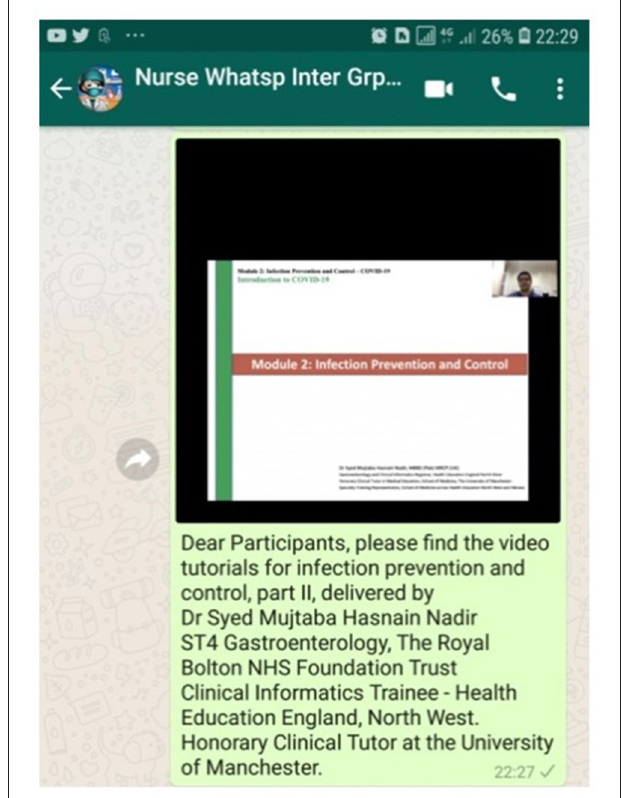
FIGURE 2 | Screenshot of a WhatsApp communication to the intervention group including a video tutorial by subject expert and introductory